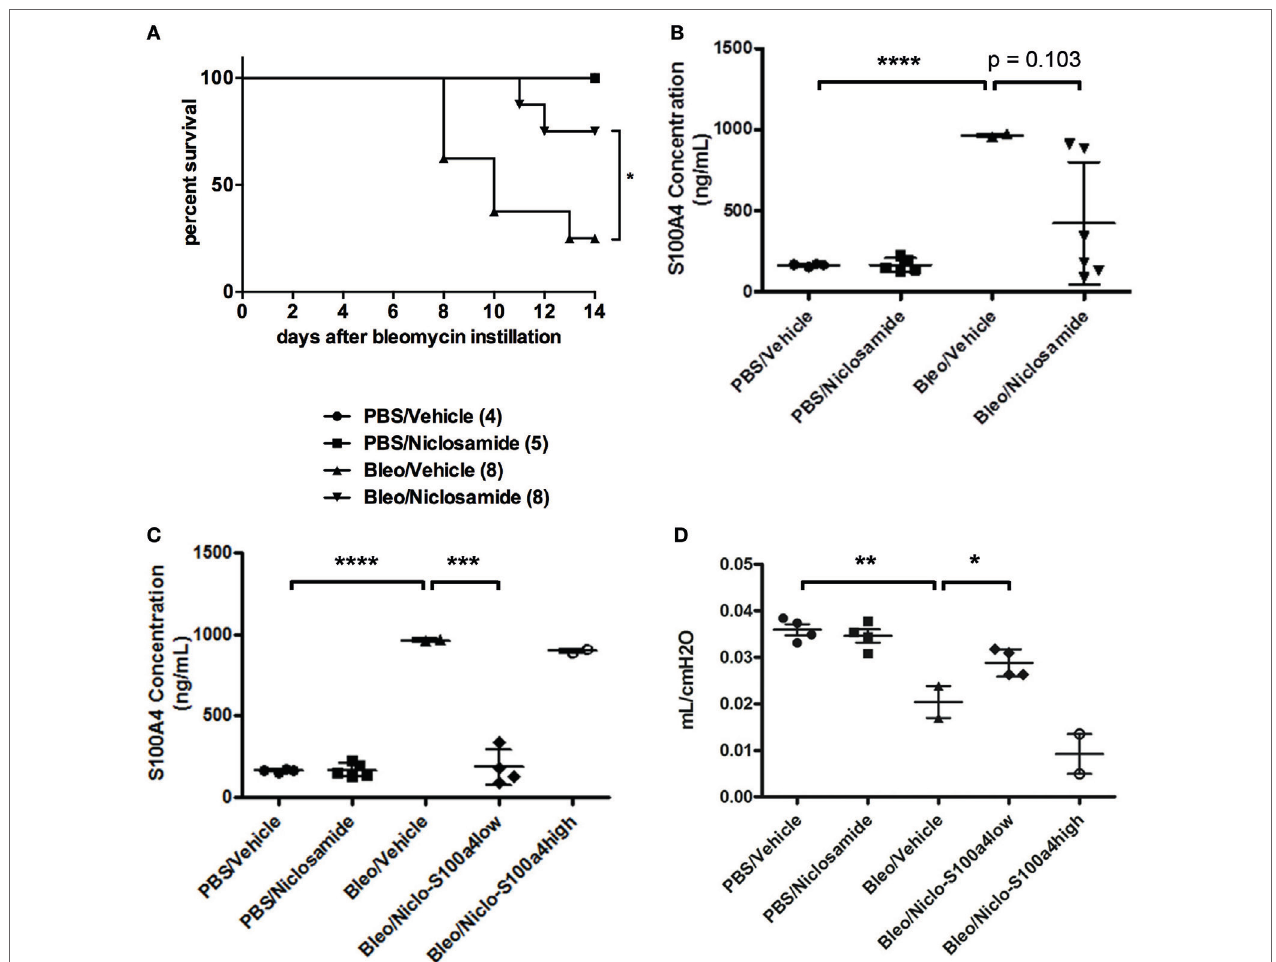
FigUre 7 | Niclosamide treatment in vivo. (a) Treatment with niclosamide improves survival of bleomycin-instilled mice. Mice were intratracheally treated with bleomycin, or as a control, with PBS. Beginning at day 7 after bleomycin instillation, mice were treated once daily with niclosamide (20 mg/kg) or vehicle. Mice were monitored daily for signs of disease, and any mice that appeared moribund were sacrificed. Treatment with niclosamide significantly improved the survival of bleomycin-instilled mice [* p = 0.031; Log-rank (Mantel–Cox) test]. Numbers in brackets indicate the total number of mice per group. (B,c) Treatment with niclosamide reduces S100a4 protein in the BAL fluid. The surviving mice depicted in panel (a) were subjected to BAL. The protein concentration of S100a4 in the BAL fluids was determined by ELISA. Each symbol represents a mouse. Results are shown as mean ± SD. Unpaired t -test was performed for statistical analysis (*** p < 0.001; **** p < 0.0001). (D) Treatment with niclosamide improves lung function. The surviving mice depicted in panel (a) were subjected to a lung function test, and lung compliance was determined. Each symbol represents a mouse. Results are shown as mean ± SD. Unpaired t -test was performed for statistical analysis (* p < 0.05; ** p <